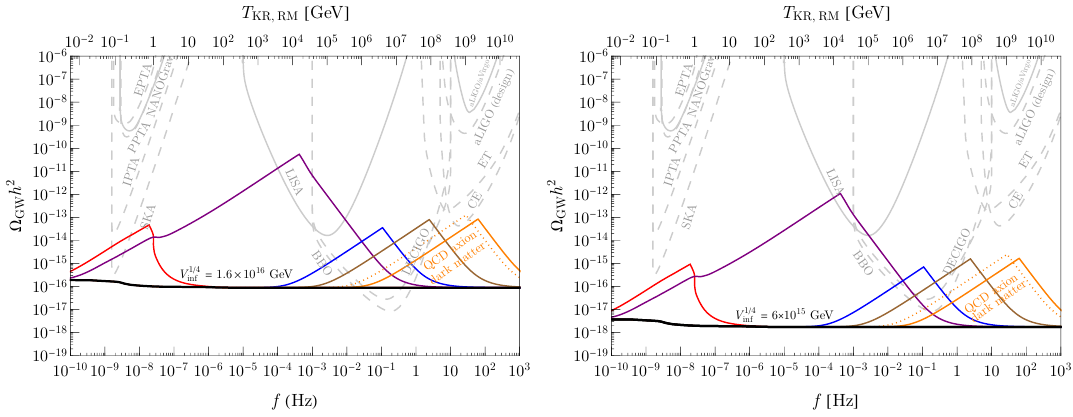
Figure 8 . GW spectra from inflation for inflationary energy scale V 1 / 4 of 1 . 6 × 10 16 GeV (left panel) inf and 6 × 10 15 GeV (right panel). Each panel contains various choices of ( T KR , T RM ) . The left (right) vertex of each triangle approximately indicates the choice of T KR ( T RM ) labeled at the top axis, while T 3 = T RM T 2 . The ( T KR , T RM ) choices are (3 MeV , 3 GeV) for red, (10 − 2 , 10 7 ) GeV for MK KR purple, (10 4 , 8 × 10 7 ) GeV for blue, and (10 5 , 3 × 10 9 ) GeV for brown. Finally, for QCD axion dark matter to be produced by kinetic misalignment with C = 1 and 0 . 3 , T KR is predicted to be 2 × 10 6 and 7 × 10 5 GeV as shown in the solid and dotted orange curves with the maximal T RM of 7 × 10 10 and 4 × 10 10 GeV allowed by the constraints shown in figure 9. These curves assume g ∗ ( T ) for the Standard Model and H with individual energy density contributions including a piecewise ρ θ